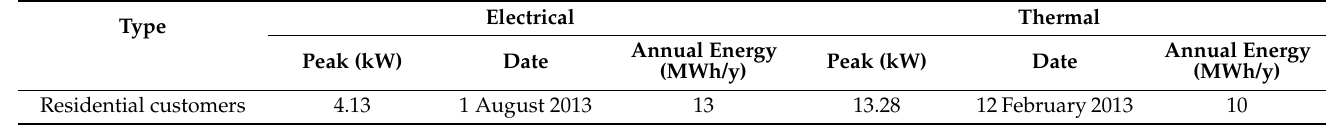
Figure 4. Example electrical and thermal load profiles for Atlanta, USA: ( a ) Instantaneous electric demand on an electrical peak day in hourly intervals; ( b ) Electric demand over one year; ( c ) Thermal demand on thermal peak day in hourly intervals; ( d ) Thermal demand over one year. Table 1. Electric and thermal loads for metropolitan residential customers in Atlanta, USA .